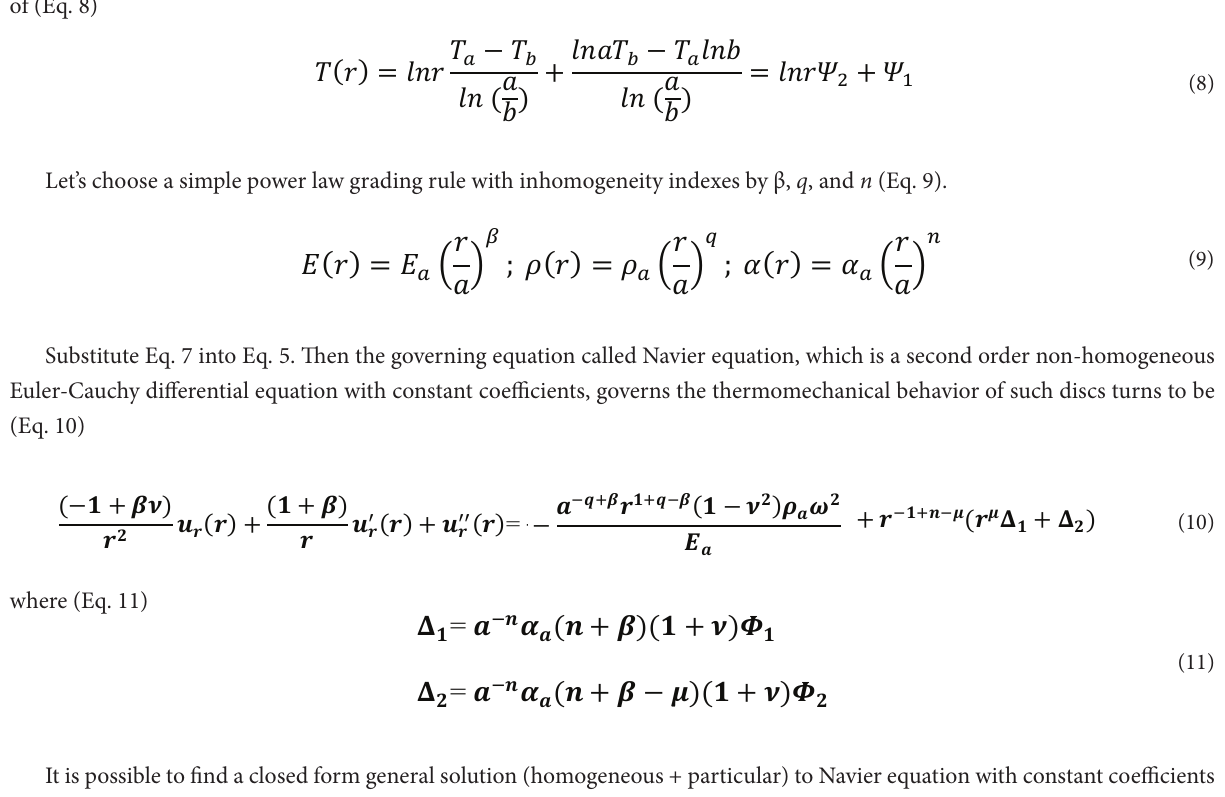
and T ( b ) = T , for a power-law graded disc, k ( r ) = k a b